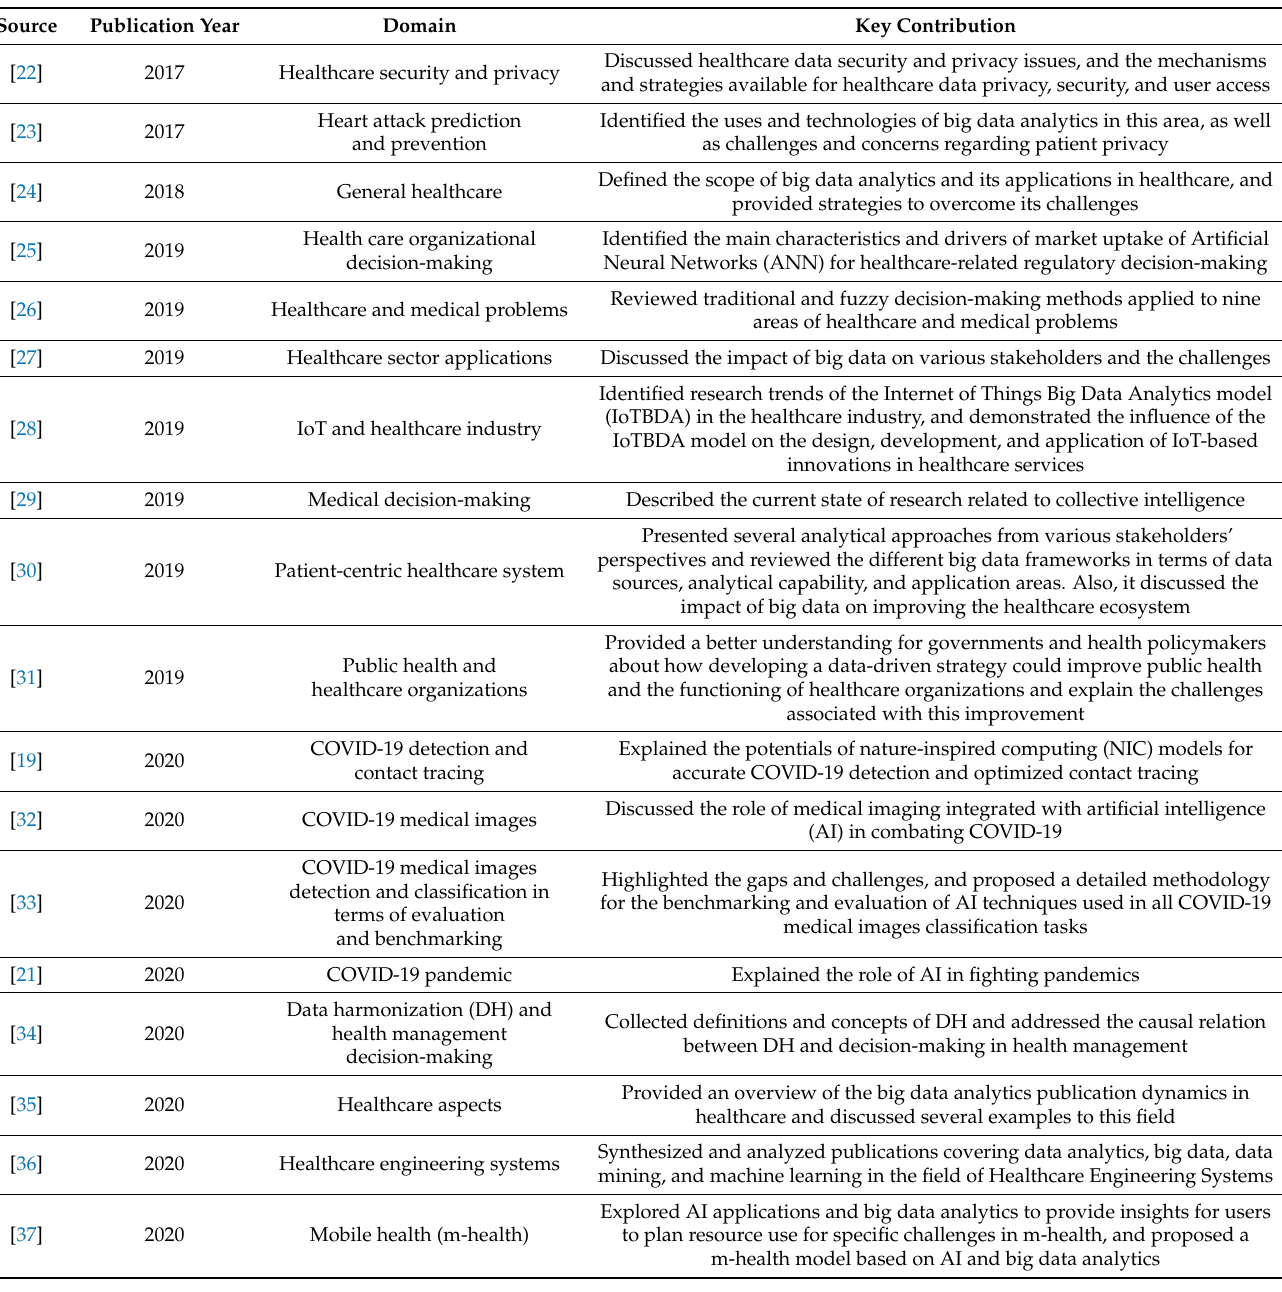
Table 1. Summary of surveys on big data analytics in the healthcare